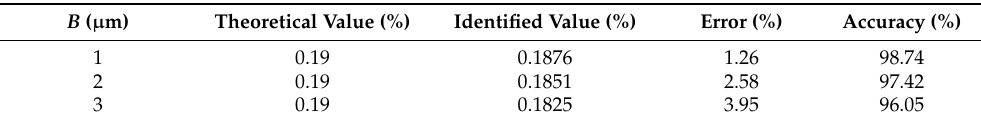
Table 3. Identified damping ratios with different steady-state